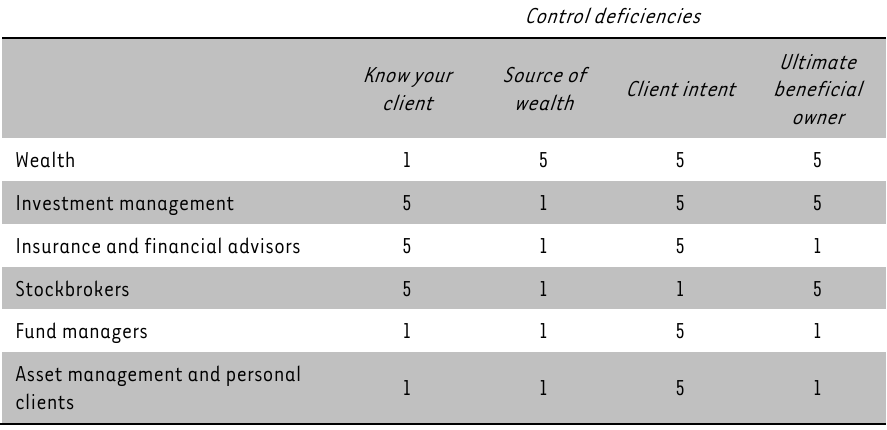
TABLE 5: Data depicted in template